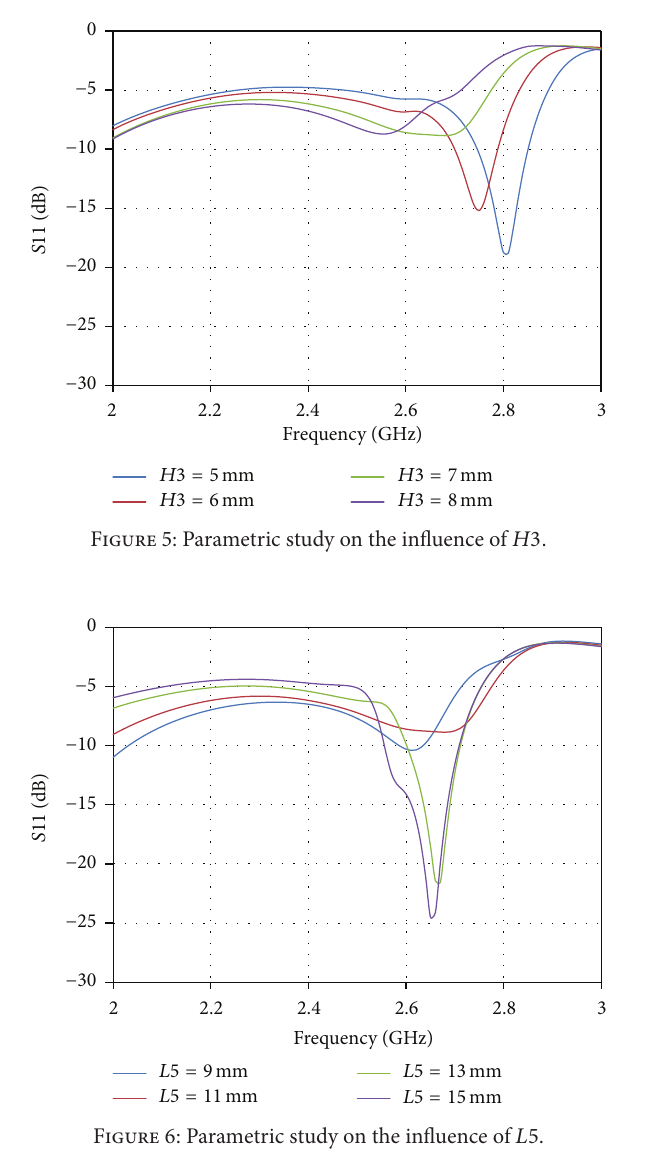
Figure 8: Simulated antenna system 𝑆 -parameters.